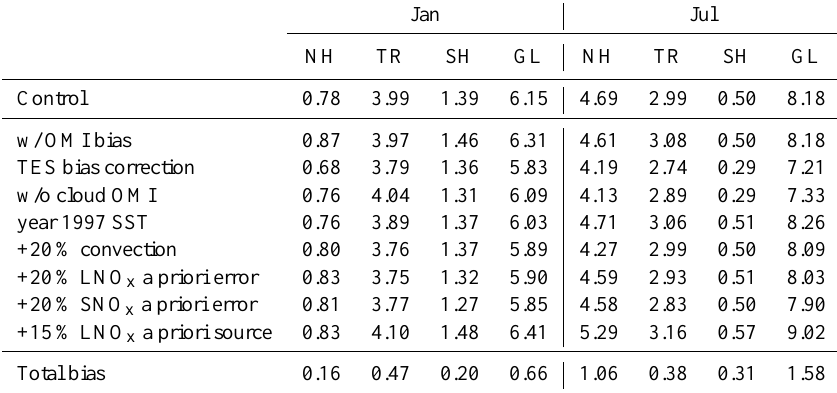
Table 6. Similar to Table 4, but lists the LNO x sources obtained from the control data assimilation run (control), with a 15% addition of artificial OMI NO 2 bias (w/ OMI bias), with the TES O 3 bias correction (TES bias correction), without the OMI cloud-covered observations (w/o OMI cloud), with the SST data for 1997 (year 1997 SST), with 20% increases in the convective mass flux (+20% convection), with 20% increases in the a priori errors of the LNO x source and the surface NO x emissions (+20% LNO x a priori error and +20% SNO x a priori error), and with 15% increases in the a priori values of the LNO x sources (+15% LNO x a priori source). The total bias due to all terms is computed as a random addition of the individual biases. See the text for